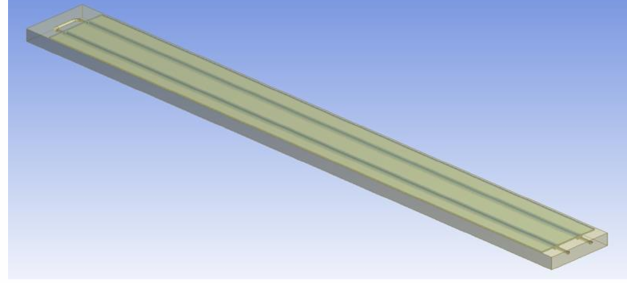
Figure 2. Modeling of the PVT collector.